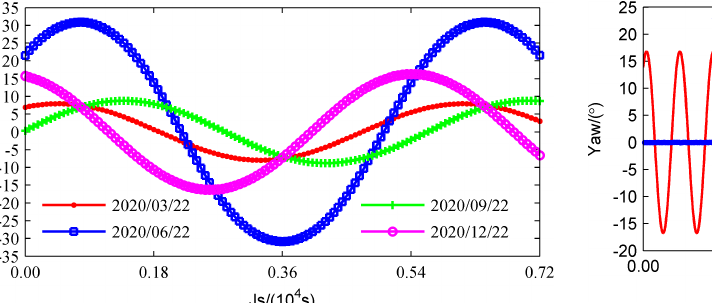
Figure 13. Observed and calculated results of the yaw angle